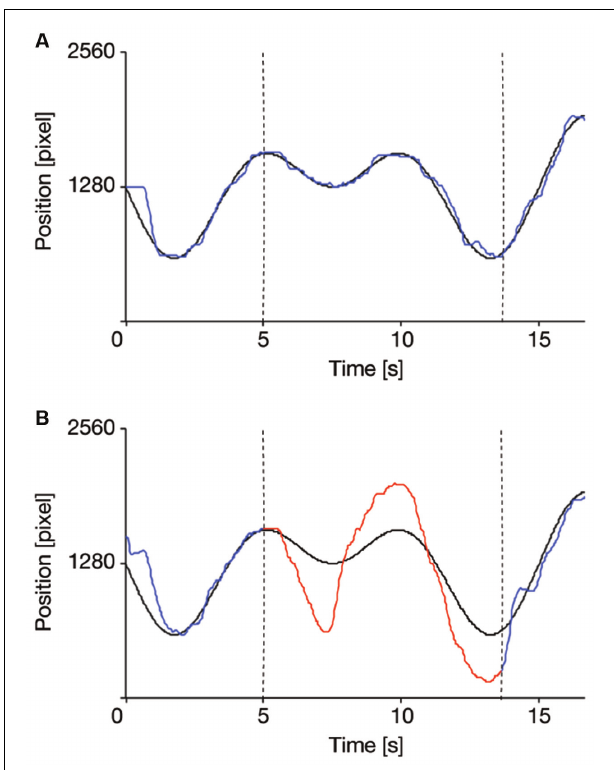
FIGURE 3 | Examples of the target and cursor movements in the visible cursor condition (VC: A , blue line) and the invisible cursor condition (IC: B , red line). The values of 0 and 2,560 on the vertical axis respectively indicate the left and right sides of the display. Dotted black lines represent epoch switching points. Black curved lines are the target trajectories, and the colored lines are the typical cursor movements of one of the participants. Note that in the IC condition (B) for the first and last epochs of each trial, visual feedback for cursor position was provided, as indicated by blue lines. These periods in the IC condition were excluded from data analysis.